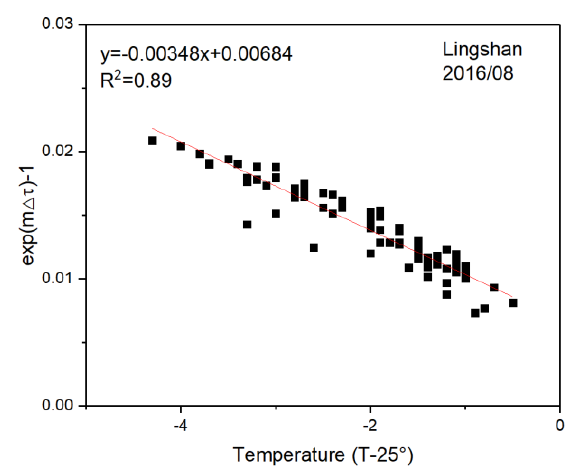
Fig. 4 Fitting results of temperature correction coefficient. One can see that the correlation of the two curves is 0.89, and the fitting temperature correction coefficient is 0.00348.